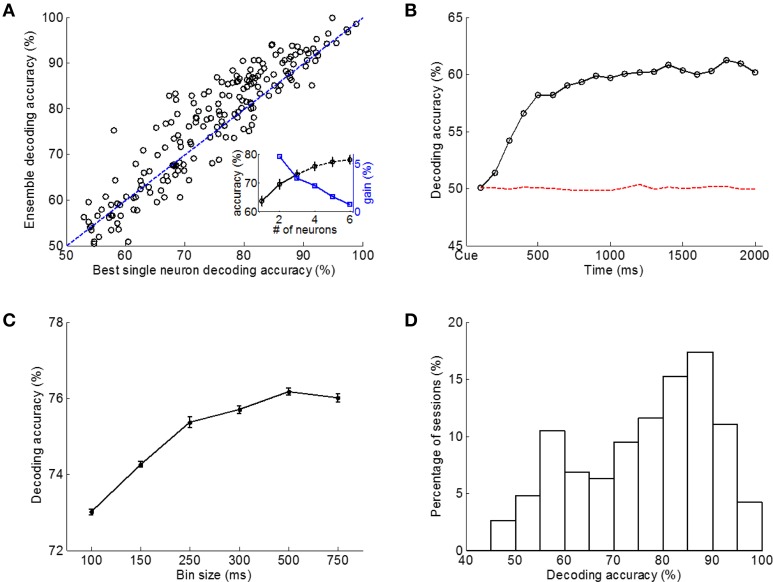
Decoding accuracy between L-L and R-R trials using linear SVM classifiers with different data and classifier configurations. (A) Classification performance using neural ensembles vs. best single neurons. CO data window, 500 ms time bins. Each point represents one of the 190 sessions, and those above the diagonal line indicate better classification performance using the ensemble. Insert: decoding accuracy increased when larger ensembles were used, but the speed of increase in decoding accuracy by using larger ensembles slowed down as ensemble size increased. (B) SVM classification accuracy using data of single 100 ms time bins, averaged over all sessions with chance level classification accuracy (dashed line) obtained using shuffled training data. (C) Bin size affected classification performance. (D) Histogram of single session SVM classification performance (190 sessions). Averaged classification accuracy (test data set) was 76.18% based on CO data window with 500 ms bins.